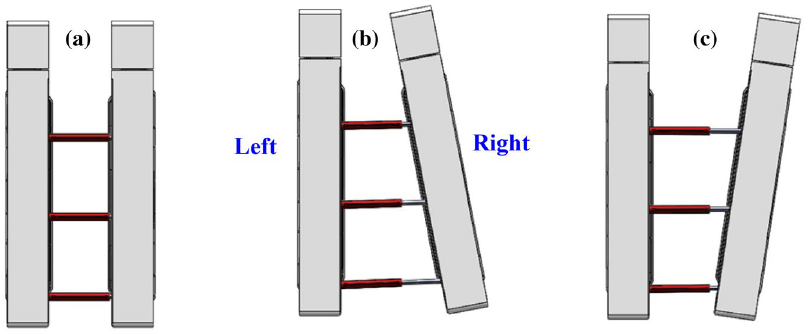
Figure 4. Left and right spacing deviation of the advance hydraulic support: ( a ) Ideal supporting state; ( b ) non- ideal supporting state (left avertence); and ( c ) non-ideal supporting state (right avertence).